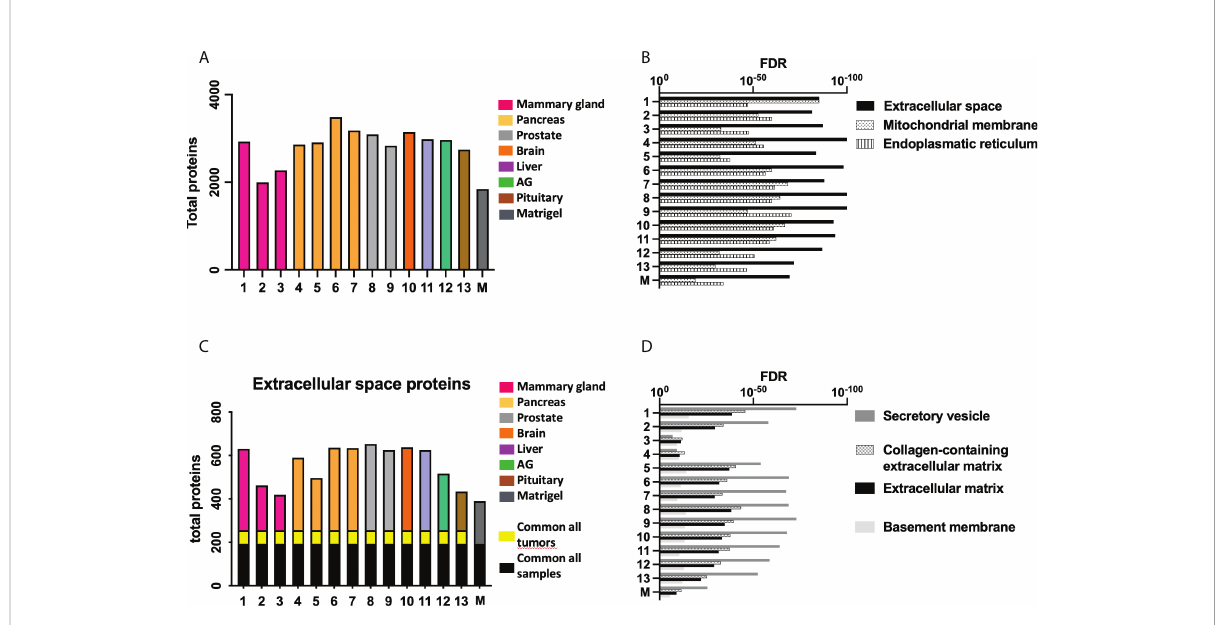
FIGURE 3 Proteomic study shows differences in ECM composition among samples. (A) Total amount of proteins detected in the proteomic study. (B) The most relevant Gene Ontology (GO) terms related to retrieved proteins in each sample. (C) The number of proteins from the GO term “ Extracellular space ” present in each sample, and the (D) GO terms related to these shortlisted proteins. Note: cell line number codes are provided in Table 1. The same tumor color codes are used in all panels of the fi